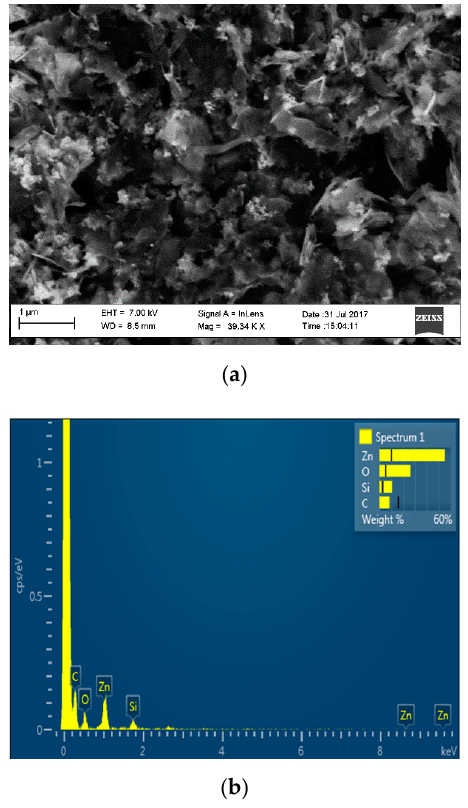
Figure 13. ( a ) Gr-ZnONPs nanocomposites observed under SEM and ( b ) EDX spectrum collected in an area surrounding ZnO